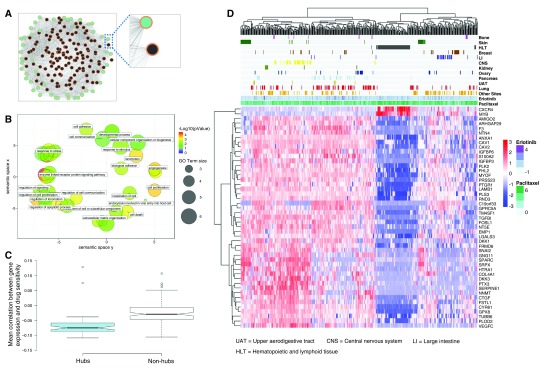
Hubs in a pan-cancer transcriptomic network display drug sensitivity predictive potential.(
A) Snapshot of a (fully connected) weighted gene correlation network from untreated cell lines. Nodes and edges representing genes and their correlations respectively. Network hubs and non-hubs are colored in green and black respectively. Nodes are connected by edges, which are depicted in a white-to-grey gradient (the darker the edge, the higher the correlation). A zoom-in view of examples of hub and non-hub nodes reveals that the hub node has more edges with higher weights compared to the non-hub node. (
B) Graphical summary of (non-redundant) Gene Ontology terms statistically over-represented in the list of 47 hub genes. Significant Biological Processes terms, represented as bubbles, are projected onto a scatterplot using REVIGO
33. Terms sharing common ancestors in the Gene Ontology database are close together; leading to a cluster of GO terms characterizing highly related biological annotations. To facilitate visualization, only a small selection of terms are labeled on the figure. Color and size indicates the term’s level of statistical enrichment in our list of hubs and frequency in the GO database respectively. (
C) Comparison of hubs vs. non-hubs on the basis of their individual associations with drug sensitivity (P < 0.0001, two-tailed, Student’s t-test). The boxplot depicts the mean correlation between the gene expression and the Activity Area (AA) values across CCLE cell lines. Box notches indicate 95% confidence interval for each median value. Non-overlapping notches indicates a significant difference at the 95% level. (
D) Cell line-drug experiments are visualized in terms of the 47-gene expression data. The panel above the gene expression heat map illustrates the AA values observed for selected sets of cancer cell lines (grouped by tissue site) and two compound examples (erlotinib and paclitaxel) for illustration purposes.